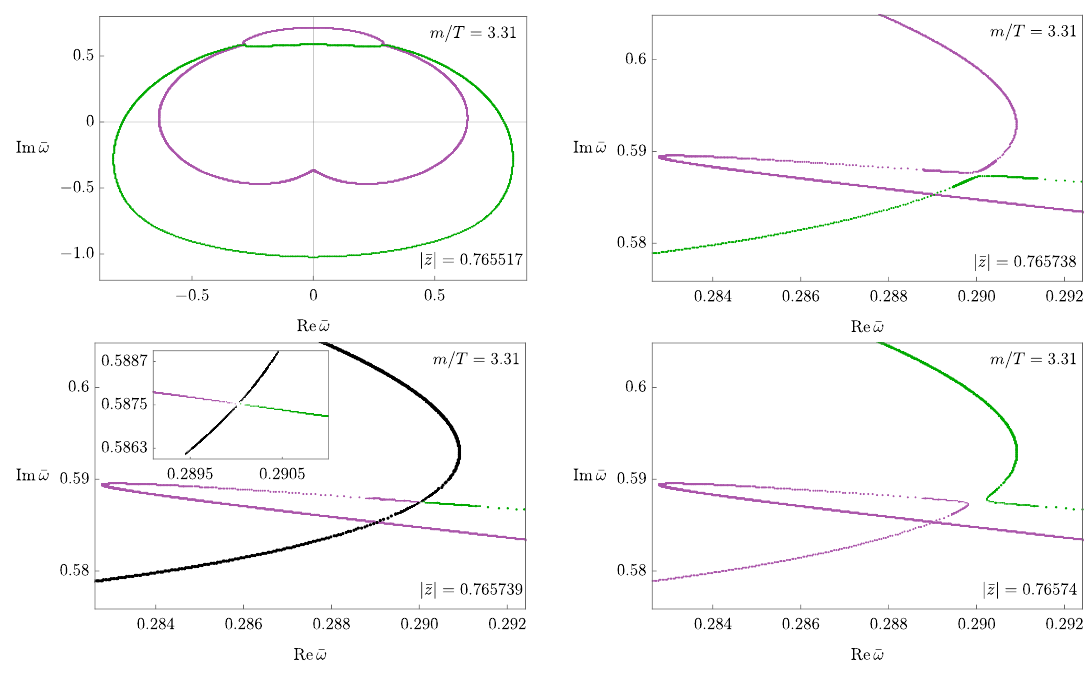
Figure 13 . Depiction of the collision between the hydrodynamic diffusive and sound modes in the longitudinal channel of the holographic solid model at m/T = 3 . 31 (Case I L ), plotting ¯ ω (¯ z ) as a function of φ in ¯ z = | ¯ z | e iφ . The green colour corresponds to the diffusive mode and the purple colour corresponds to the sound modes. The top two plots represent the modes’ trajectories before the collision (a zoomed-out and a zoomed-in version at slightly different | ¯ z | ). At the value of | ¯ z | that results in a collision (a critical point), which is depicted in the bottom left plot, the curves are marked in black after they collide because the two hydrodynamic modes cannot be distinguished. The bottom right plot shows level-crossing of the two modes for | ¯ z | larger than that of the critical point.